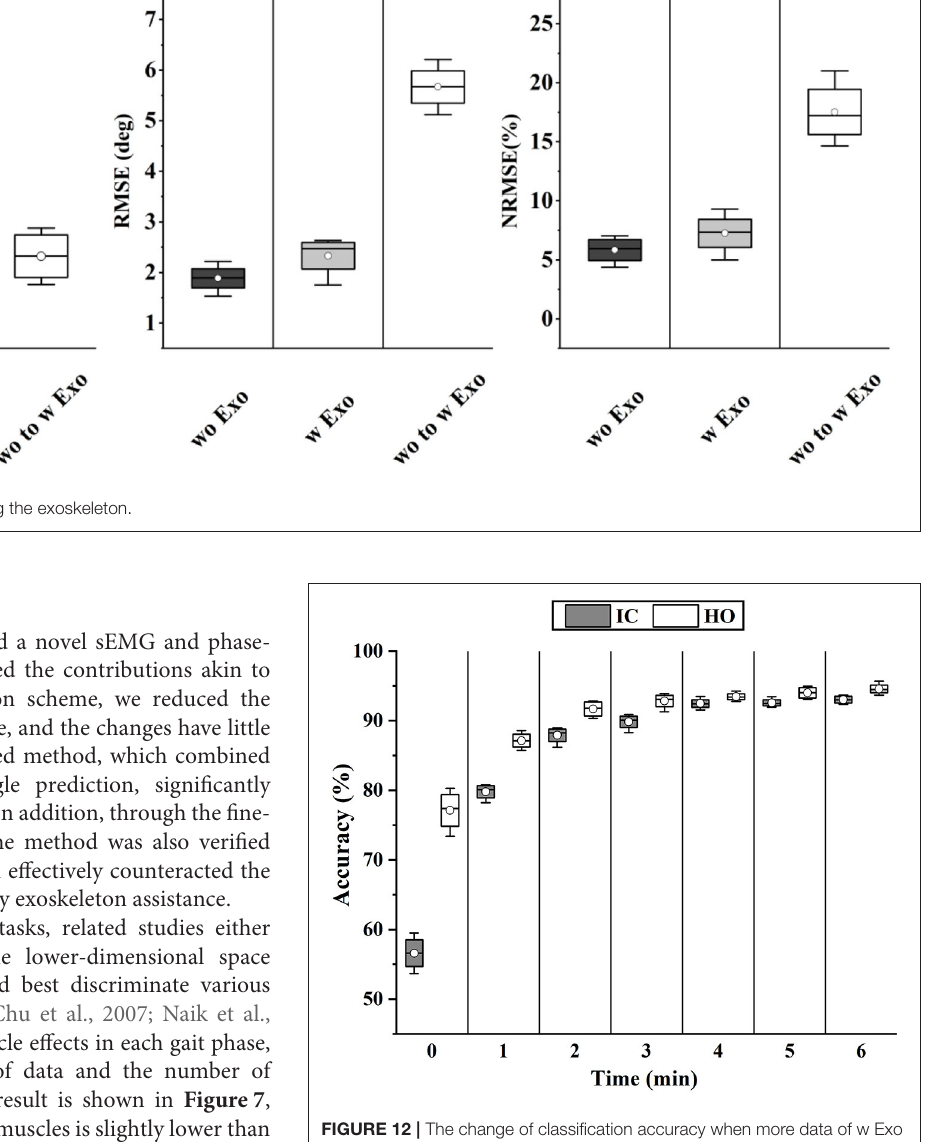
FIGURE 12 | The change of classification accuracy when more data of w Exo was added to update the fine-tuning-based